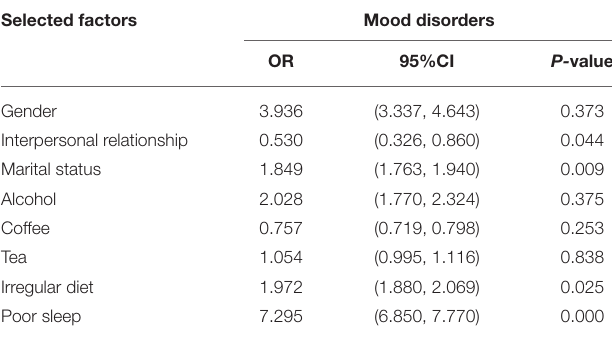
TABLE 4 | Multivariate logistic regression analyses on selected factors associated with mood disorders. Selected factors